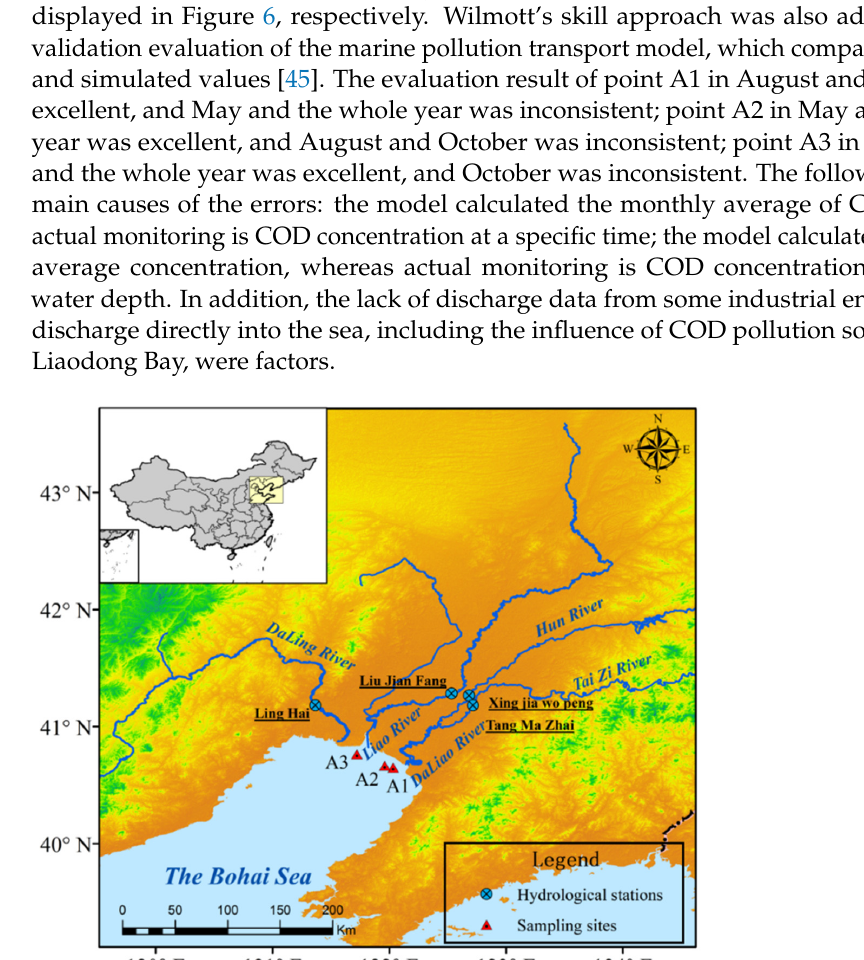
Figure 6. Measured and simulated situations of sea area points A1, A2 and A3. 4.2. Effects of Major Inlet Rivers on COD in Liaodong Bay. The study simulated the seaward process of COD in major rivers, such as Daliao, Liao, and Daling Rivers, from 1 January 2018 to 31 December 2018 [46], the distribution in Liaodong Bay, the influence range, and the change of pollutant concentration in different sea areas. It also stimulated and estimated COD contamination in the Liaodong Bay marine region by major inlet rivers under runoff circumstances in spring (April), summer (August), and winter (December) of 2018. According to the simulation, the influence of